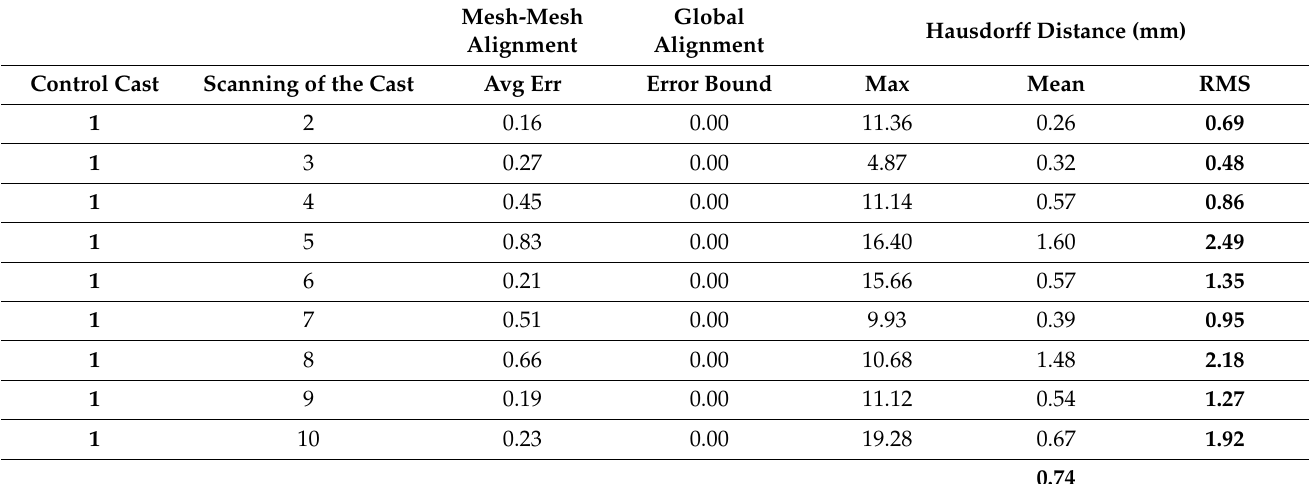
Figure 2. Scanning of the foot without any foot locking system and a handheld 3D scanner ( a ), and scanning of the foot with a foot locking system and a tripod for the 3D scanner ( b ).